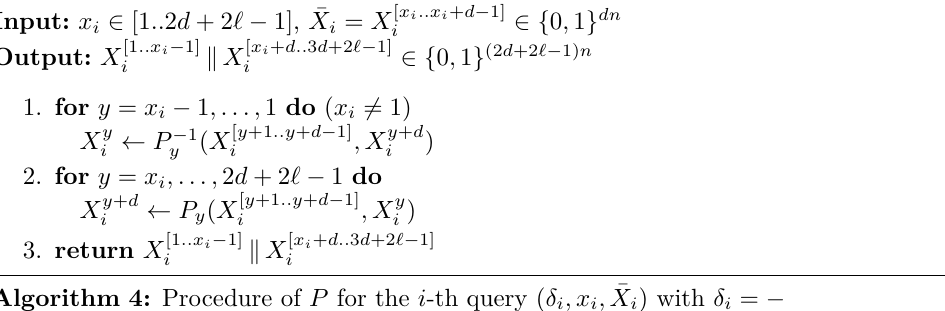
¯ X i , x i , i ) with δ i = +